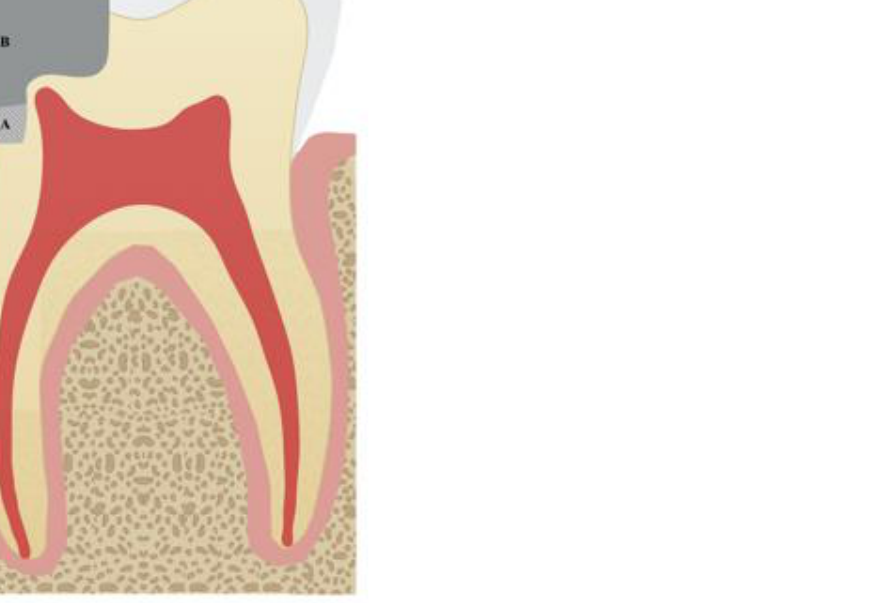
Figure 2. The deep margin elevation concept. ( A ) A layer of sub-gingival composite. ( B ) The final restoration.